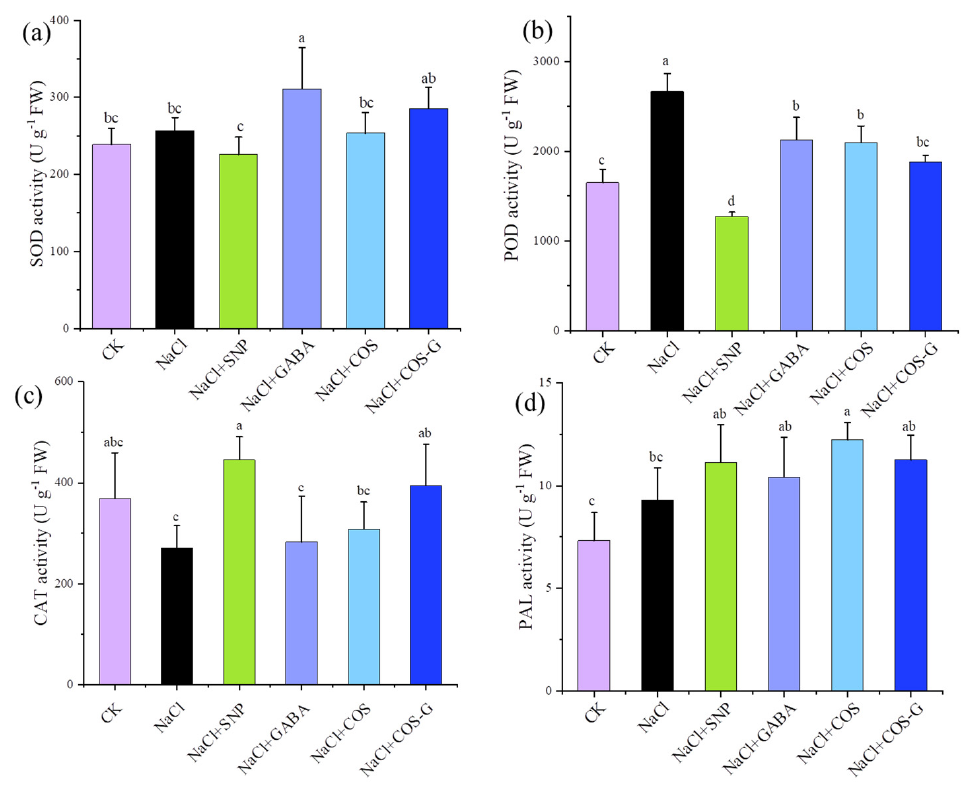
Figure 7. Effects of different treatment groups on the activity of antioxidant enzymes in wheat seedling leaves under salt stress. ( a ) superoxide dismutase (SOD); ( b ) peroxidase (POD); ( c ) catalase (CAT); ( d ) phenylalanine aminolysis enzyme (PAL). Values are the mean ± SD of three replicates in independent experiments. Different letters ( a,b,c,d ) indicate significant differences at p < 0.05 on the same parameter.